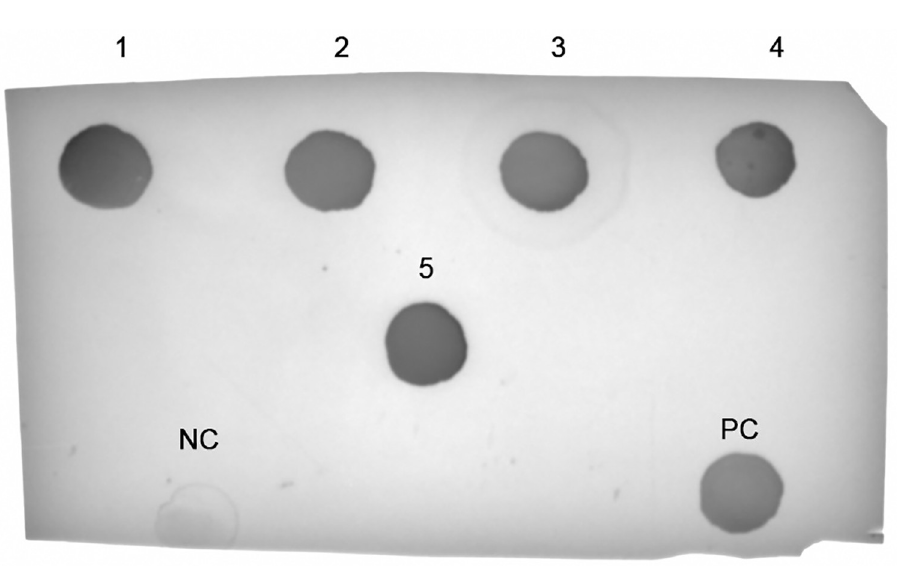
Fig 4. Dot Blot analysis of different chimeric NPs displaying β barrel for the detection of exposed antigen. (1) β barrel-ferritin, (2) β barrel-mI3, (3) β barrel-Encapsulin, (4) β barrel-CP3, (5) β barrel-HBcAg, (NC) Negative control represented by naked ferritin, (PC) Monomeric β barrel used as positive